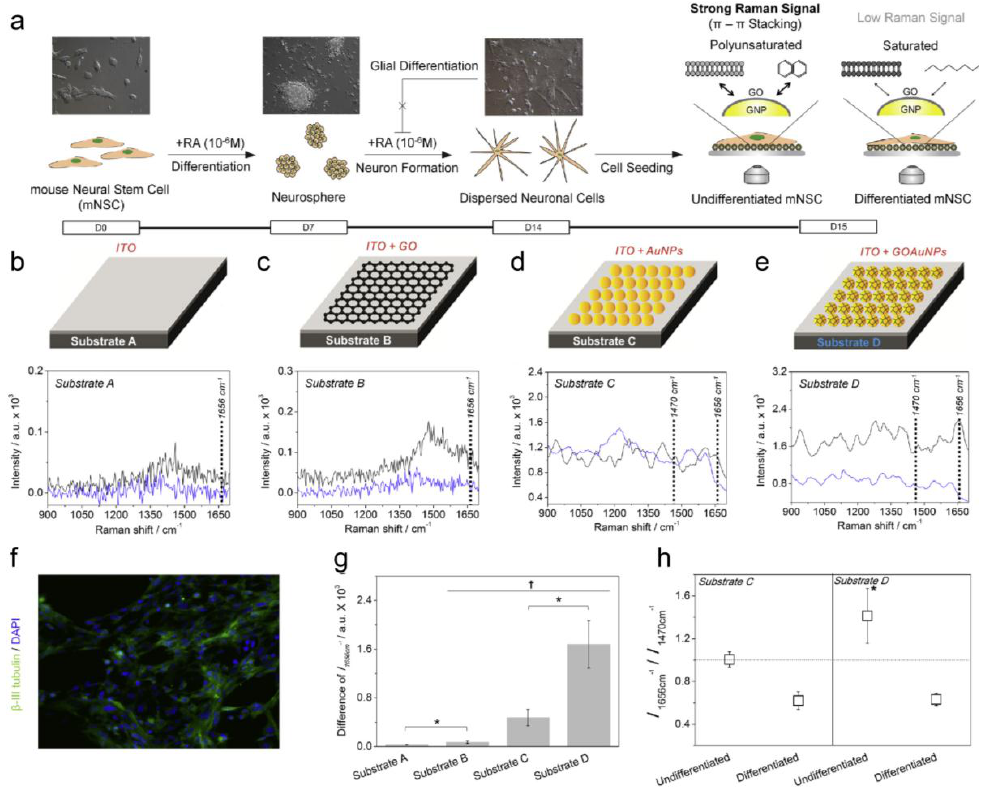
Figure 3. ( a ) Schematic diagram representing the method to detect the undifferentiated and differentiated state of the mouse neural stem cells (NSCs) using 3D GO-encapsulated gold nanoparticles. Raman spectra of (Full-size image (2 K)) undifferentiated or (Full-size image (2 K) differentiated mNSCs on ( b ) Substrate A: indium tin oxide (ITO); ( c ) Substrate B: GO coated ITO; ( d ) Substrate C: AuNP coated ITO and ( e ) Substrate D: GO-encapsulated AuNP coated ITO; ( f ) Confocal fluorescence images of differentiated mNSCs on Substrate D showing the successful differentiation of mNSCs to neuronal cells; ( g ) Intensity difference of Raman peaks at 1656 cm − 1 (C double bond; length as m-dashC bond) achieved from undifferentiated mNSCs subtracted by differentiated cells († p < 0.05, N = 3, ANOVA test and * p < 0.05, Student’s t -test); ( h ) Relative values of the Raman intensity at 1656 cm − 1 divided by the intensity at 1470 cm − 1 . All the Raman spectra of the mNSCs were subtracted by the Raman spectra of the same substrates without cells to eliminate the background signals. The results are the medians of the Raman signals obtained from ten different spots. (Modified from Ref. [24] with permission, Copyright 2013